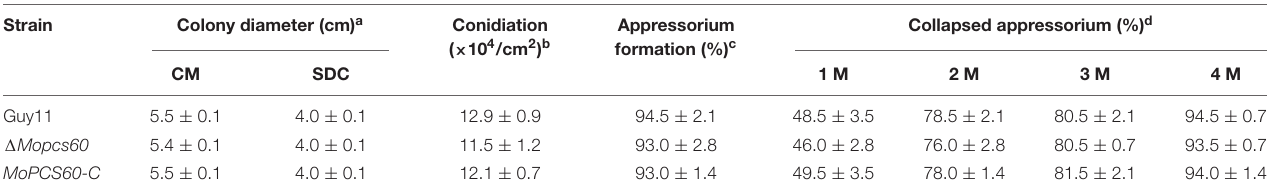
± Standard deviation ( ± SD) was calculated from three repeated experiments. a Colony diameter of the indicated strains on CM and SDC media after 7 days of incubation at 28 ◦ C. b Quantification of the conidial production of the indicated strains from 10 days of SDC cultures. c Appressorium formation on hydrophobic surfaces at 24 h postinoculation